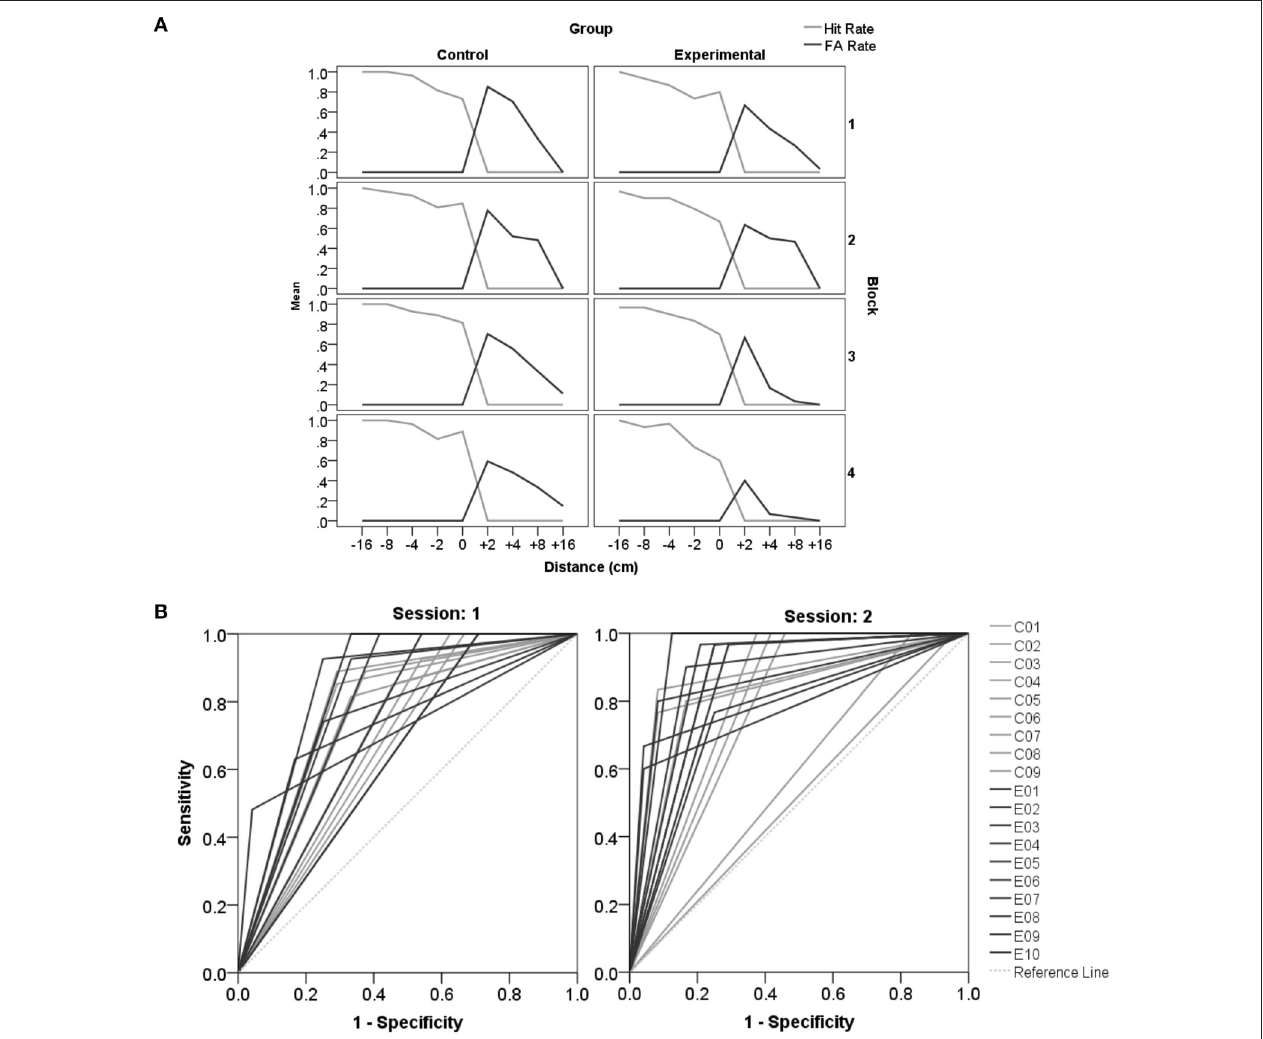
FIGURE 9 | Detection theory approach for reachability judgments. (A) Displays an overview of changes in Hit- and FA Rates for the different distances across all blocks (session1: block1 and 2, session2: block 3 and 4). (B) Displays the ROC curves for individual participants (C, Control-group; E, Experimental-group) for each session. Accuracy improves significantly after feedback in the second session.